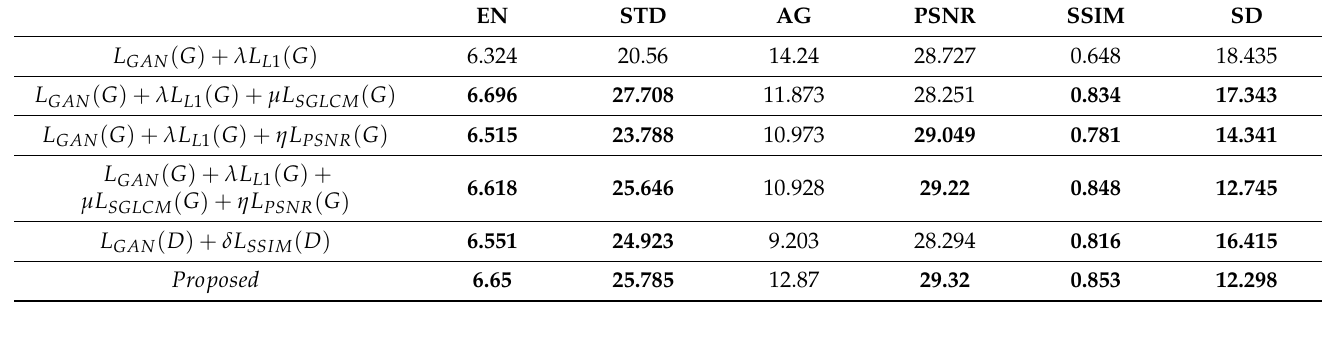
Table 2. Fusion effect of different loss functions.